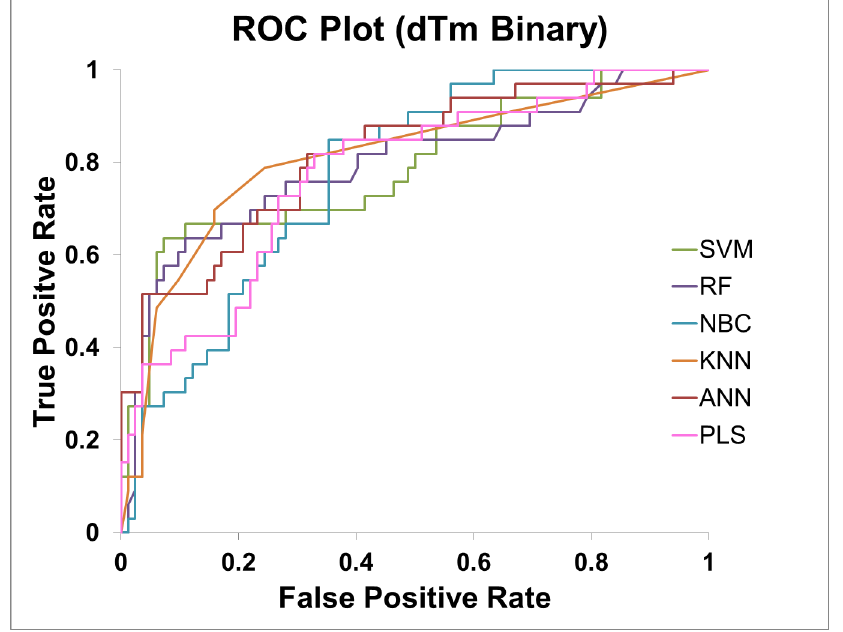
Fig 7. The ROC curves of dTm binary classification models for predicting the “ unseen ” data.